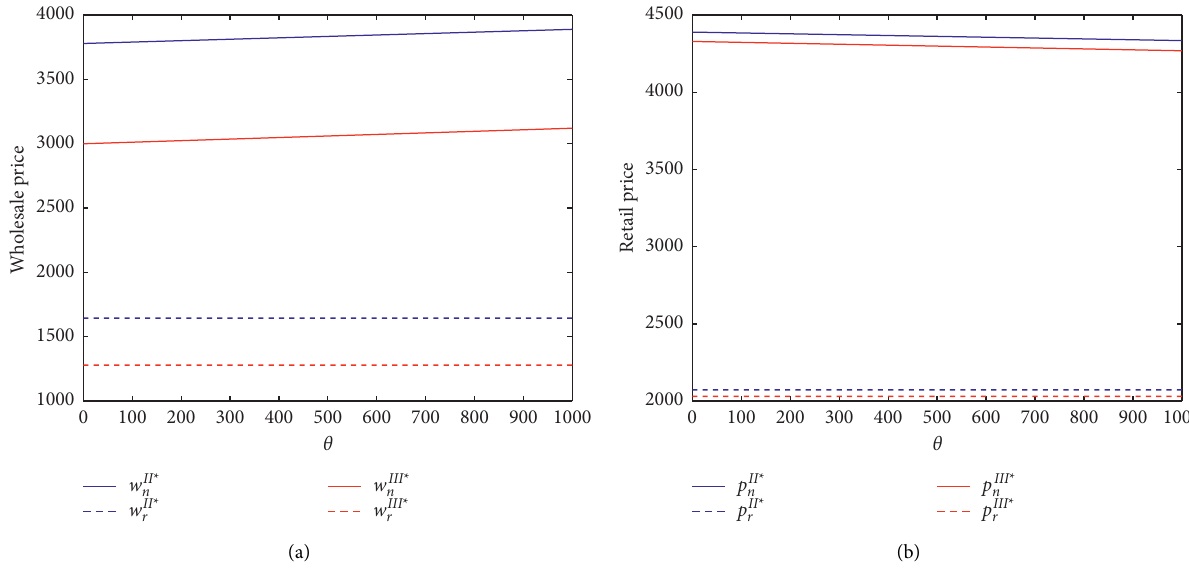
Figure 8: The effects of θ on prices. (a) Wholesale prices. (b) Retail prices.